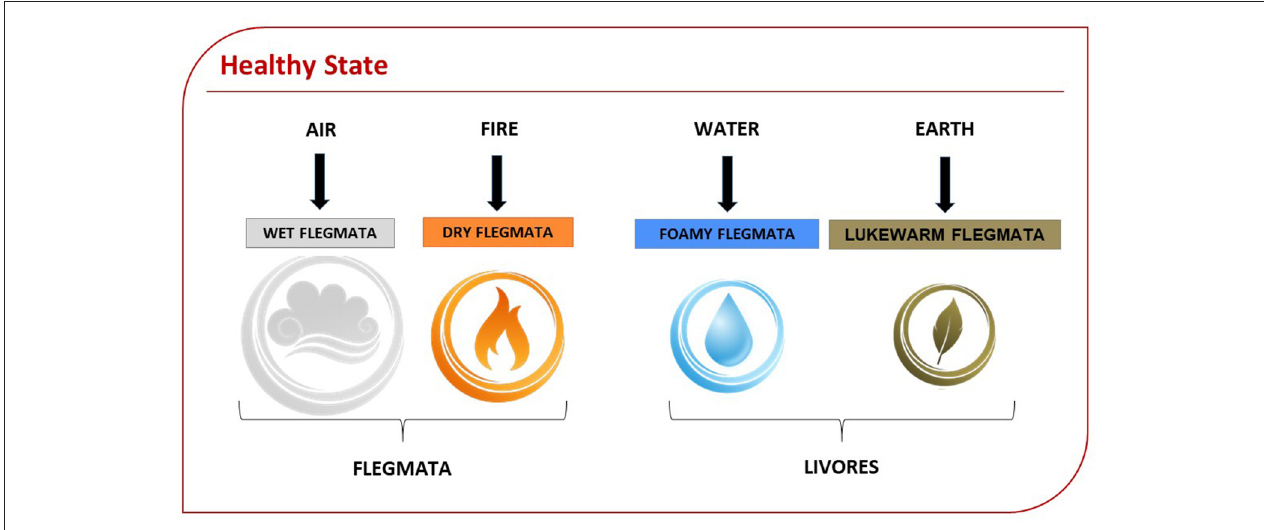
FIGURE 4 | Health state based on Humoral Theory: Humors have decreasing proportions. The first flegmata defines innate temperament. Here is represented the physiology corresponding to the state of health (resilient). The wet flegmata corresponding to the element of air is, for Hildegard, “the nerve’s and rationality’s way,” confirming that the senses and the thoughts play a central role in balancing